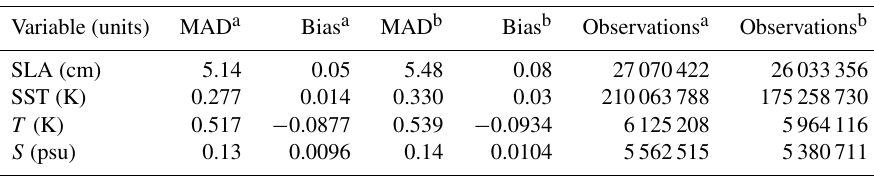
Figure 2. The analysis–forecast scheme used to compare the 3-day with the 1-day cycle system. Table 1. Global mean behind-real-time forecast innovation mean absolute deviation (MAD) and bias for sea-level anomaly (SLA), sea surface temperature (SST), subsurface temperature ( T ) and salinity ( S ) from the 1-year behind-real-time period for 2013. See Fig. 2 for cycle scheme. Total number of super-observations used in 2013 shown.